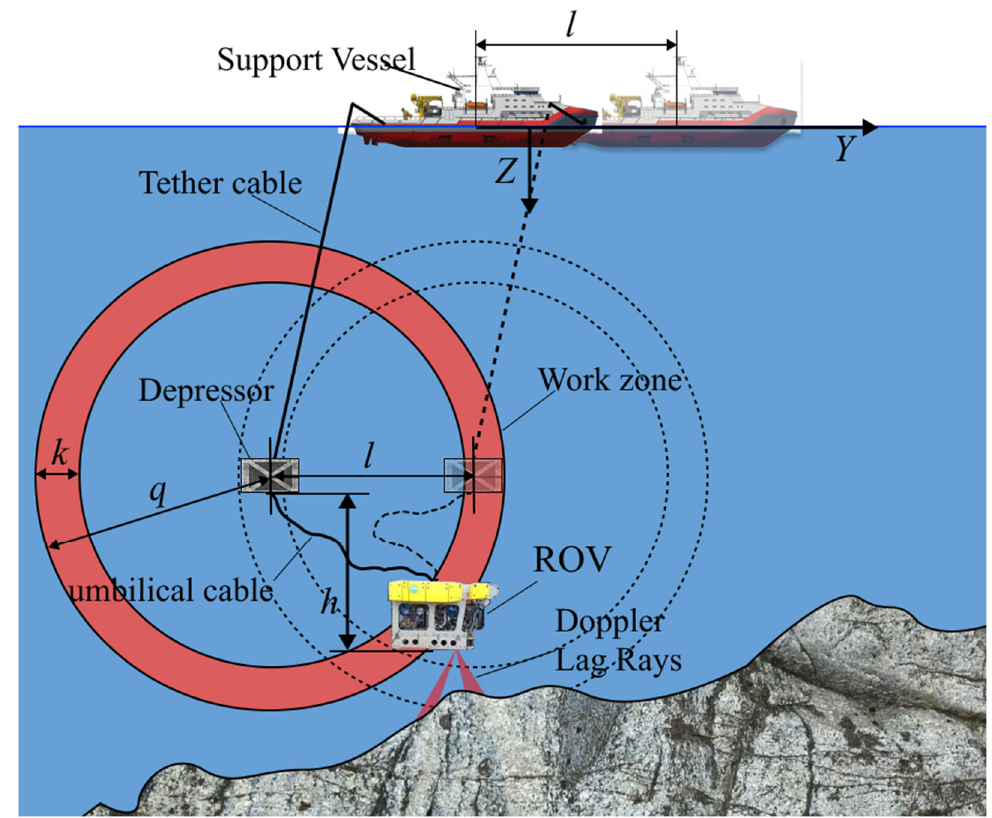
Figure 1. A ROV system deployed